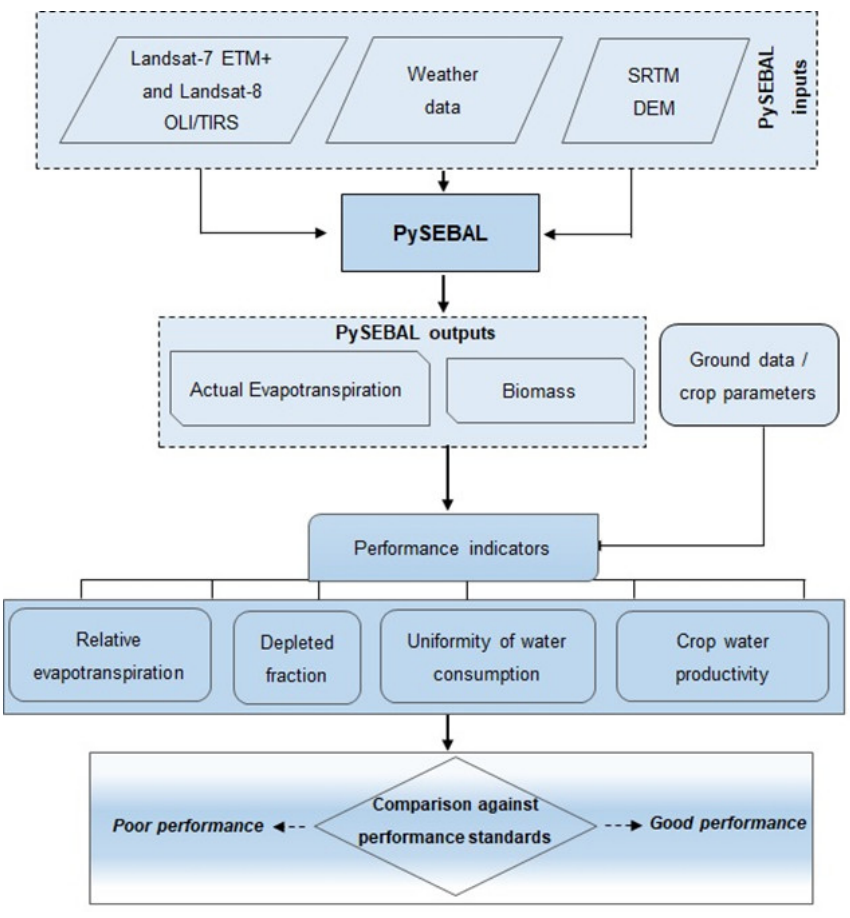
Figure 2. Schematic flowchart describing the approach used for assessing irrigation performance in the Kou Valley irrigation scheme.